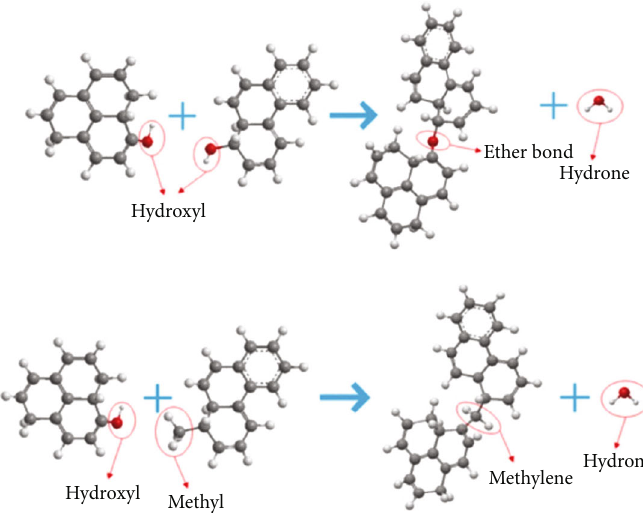
Figure 3: Scheme of complex catalytic reactions when organic matter is exposed to microwave radiation [33].